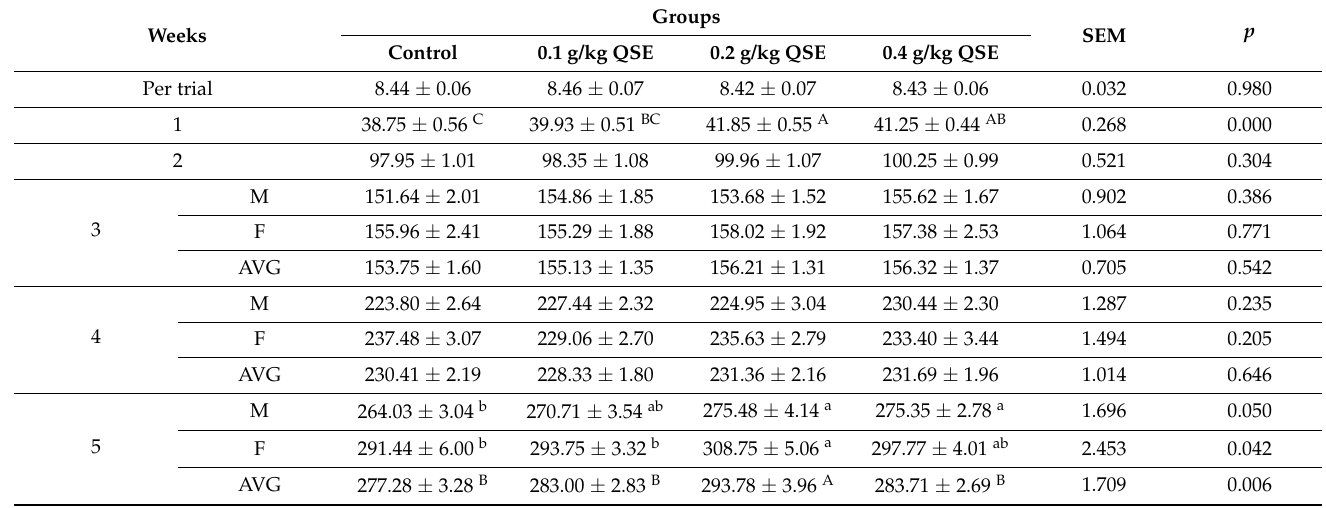
Table 1. Weekly live weight values of experimental groups